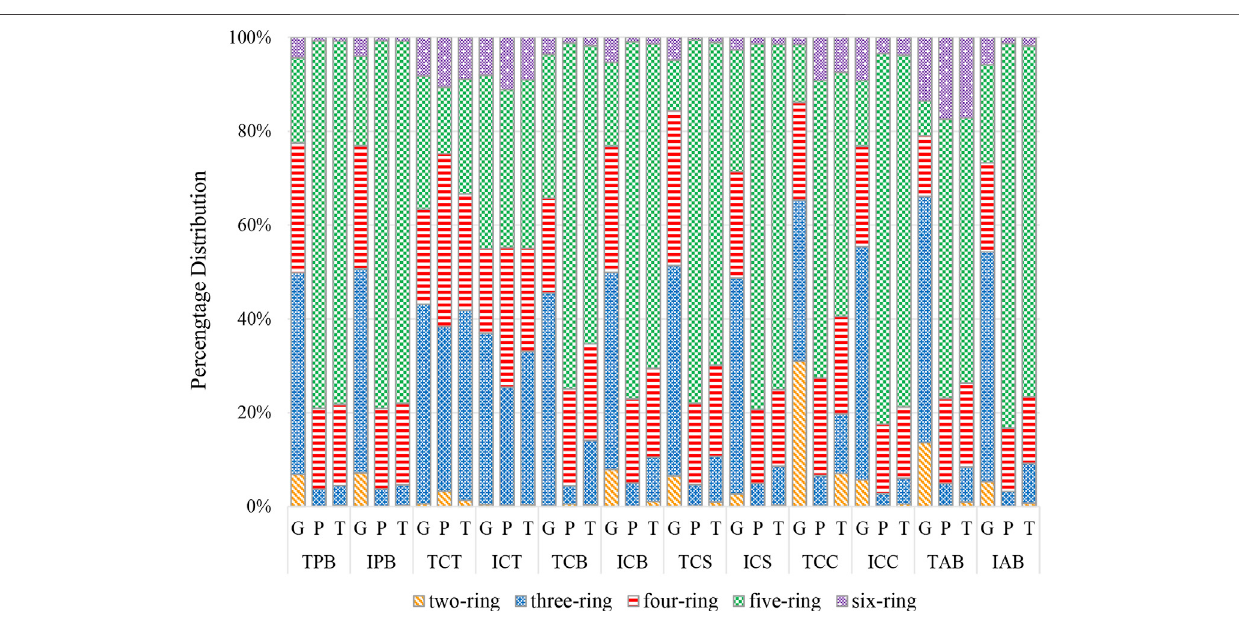
Frontiers in Environmental Science |